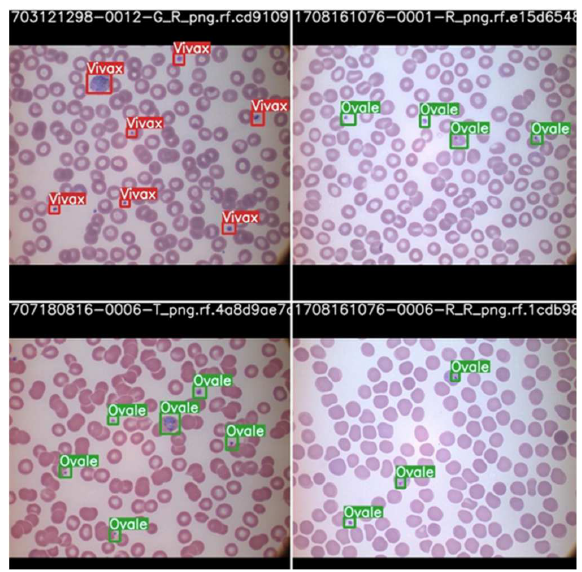
Figure 13. Parasite classification by scaled YOLOv4 algorithm after testing.